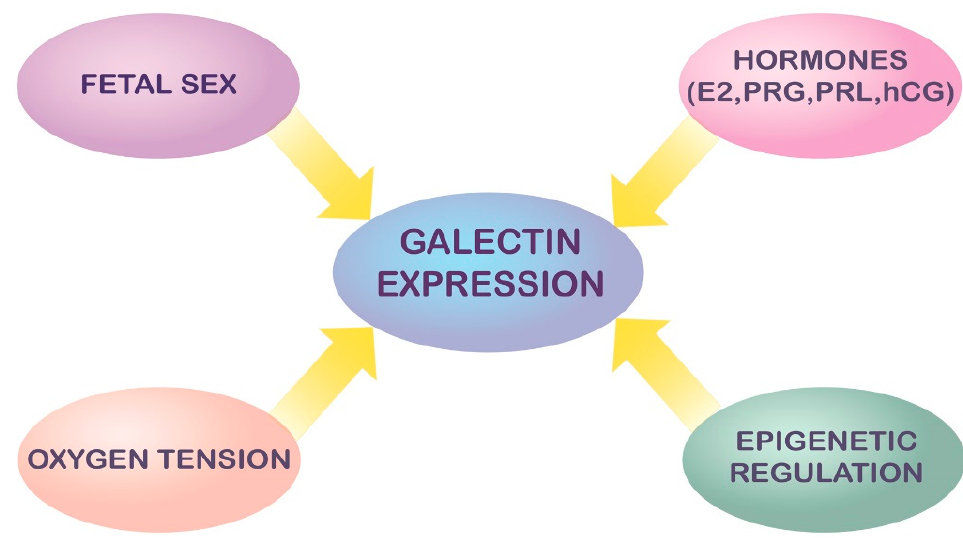
Figure 2. Suggested regulators of galectin expression in pregnancy.